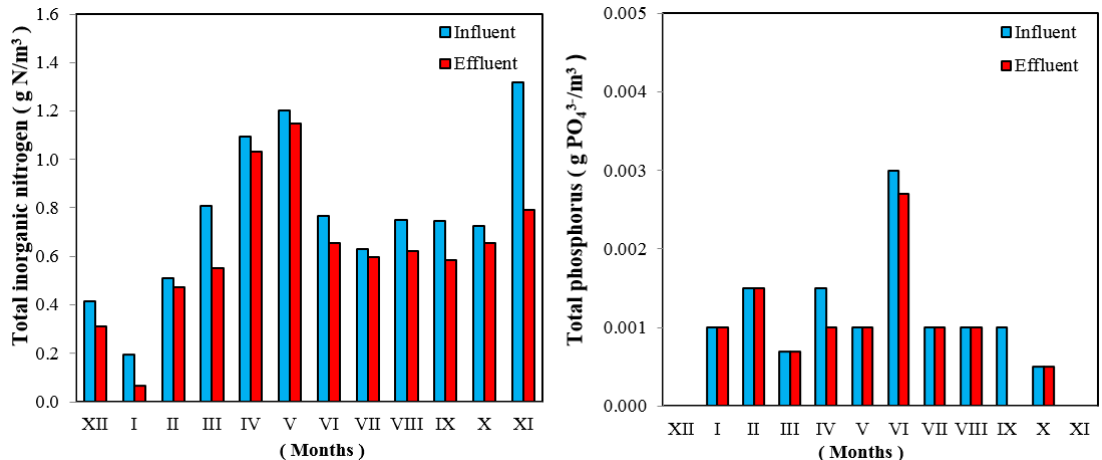
Figure 10. Average monthly values of total inorganic nitrogen and total phosphorus in water before and after the biofiltration